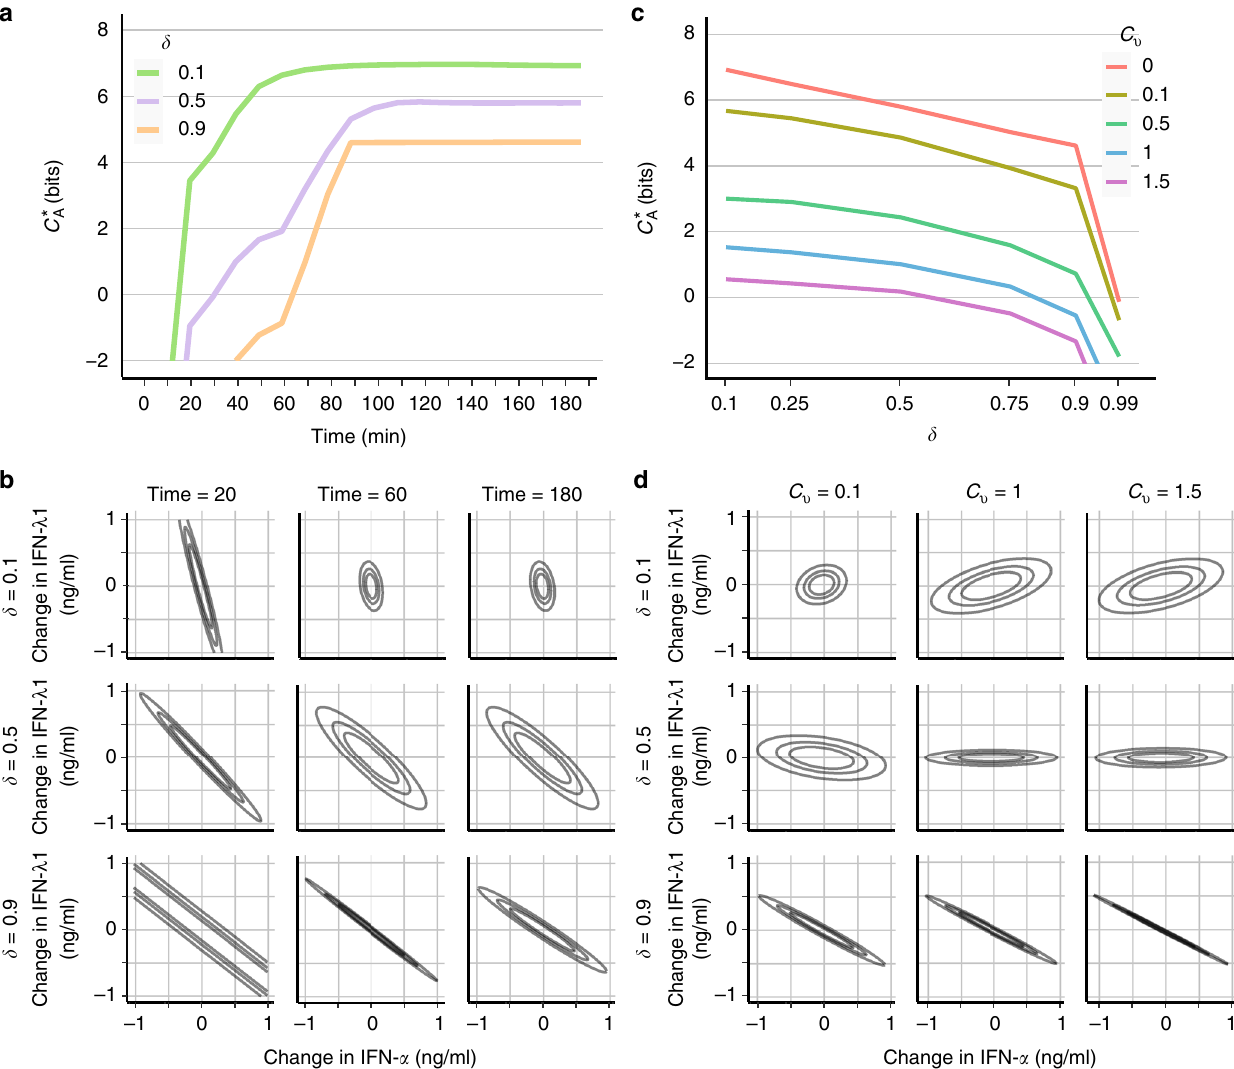
Fig. 4 Signaling dynamics has a potential to transfer information about identity and quantity of IFN- α and IFN- λ 1. a Information capacity, C (cid:1) A , as a function of the length of the output, t n , for different values of the differential kinetics coef fi cient, δ , and the coef fi cient of variation c v = 0. b Isolines of the quadratic forms ( x − x 0 ) T FIM( x 0 )( x − x 0 ) for FIMs corresponding to different values of t n and δ . Given Eq. (11), these isolines show concentration changes that are detected with the same error. Further isolines have smaller error. Singularity (parallel lines) implies lack of discriminability. c Information capacity, C (cid:1) A , as a function of the differential kinetics coef fi cient, δ for different values of c v assuming maximal considered output length, i.e., t n = 180. d As in b but for FIMs corresponding to c . Non-singularity of FIM indicates that both IFNs can be discriminated for suf fi ciently large number of cells. Modeling details: In b and d , we used x 0 given by the receptors K d ’ s, i.e., x 0 ¼ ð k I (cid:5) = k I þ ; k III (cid:5) = k III þ Þ . Remaining parameters used for computations are given in Supplementary Tables 1 and